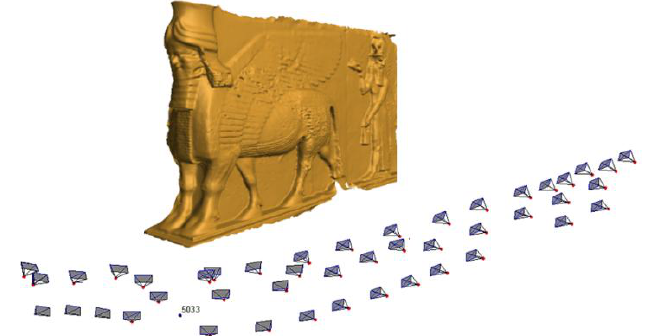
Figure 11. The dense imaging network configuration.